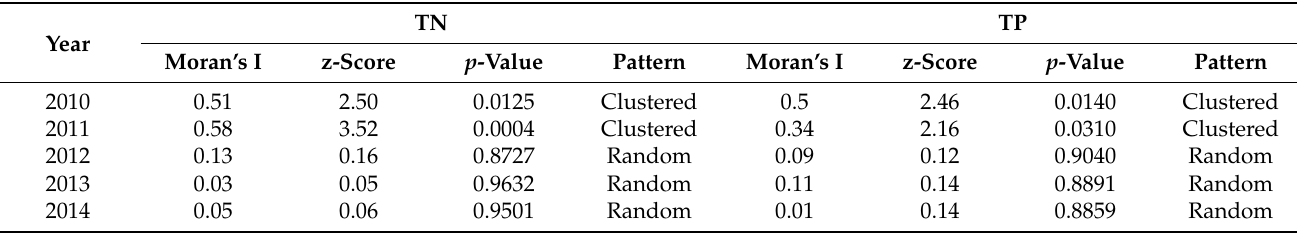
Table 5. Moran’s I of TN and TP concentrations at monitoring sites from 2010 to 2014.